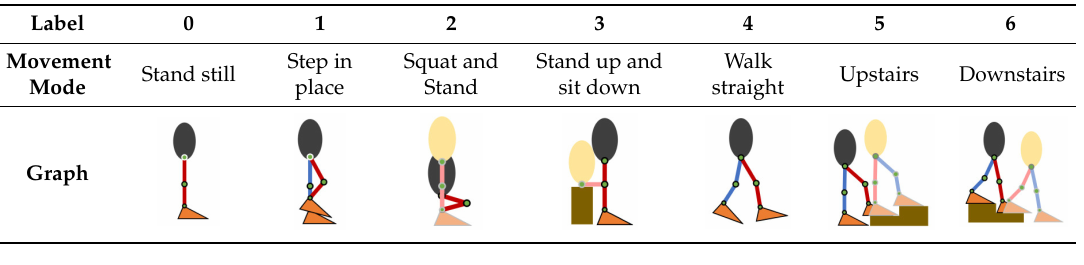
Table 1. Labels and human movement